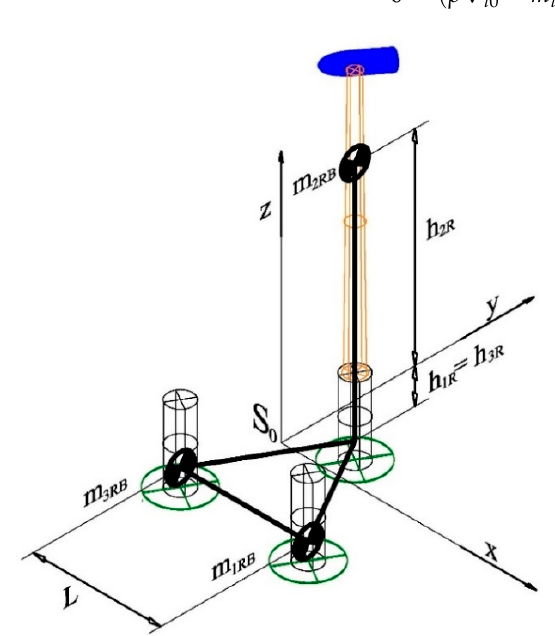
Figure 2. Distribution of the rigid body masses.